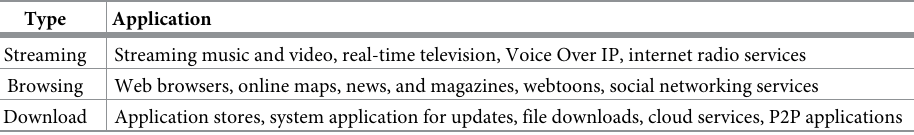
Table 2. Applications for traffic analysis